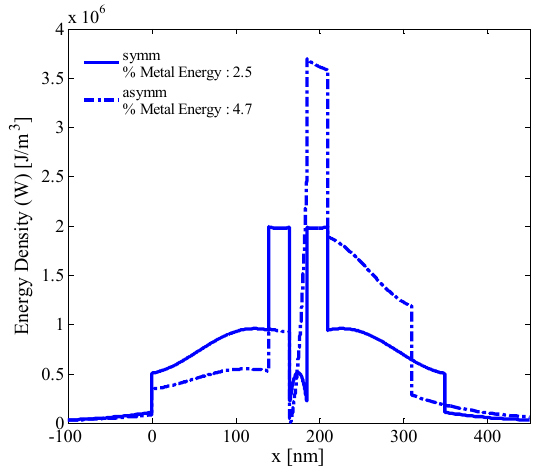
Figure 7: Energy Density of the long-range TM 1s mode at the cross-section of HIMI slab waveguide with d L =25 nm, for: 1. symmetrical case with d H =140 nm, and 2. asymmetrical case with d H1 =140 nm and d H2 =100 nm. Percentage of energy in metal layer is also included for